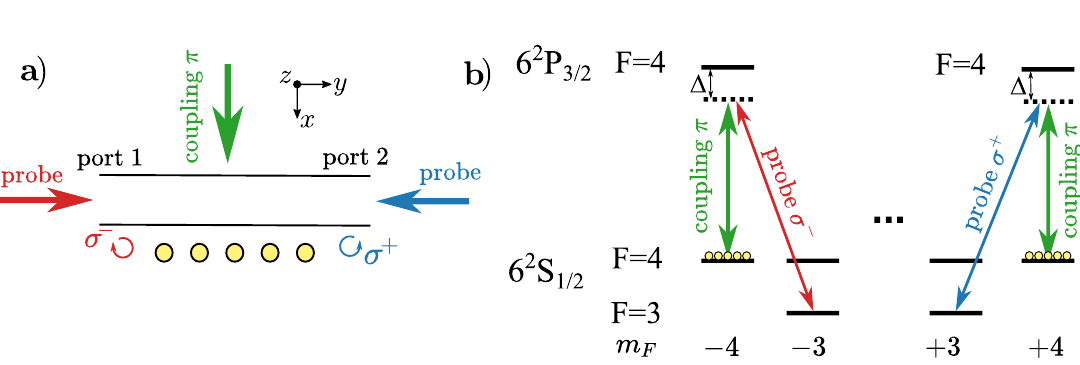
Figure 1. a) We trap cesium atoms (yellow circles) in a 1D array of trapping sites, close to an optical nanofiber. A probe laser field is launched either into port 1 or port 2 of the waveguide and interacts with the atoms via the evanescent part of the nanofiber-guided mode. The probe field is either predominantly σ − - or σ + - polarized at the position of the atoms. A π -polarized coupling laser field illuminates the atoms from the side. b) Energy levels relevant to our scheme. The atoms are initially prepared in | 6 2 S 1 / 2 , F = 4 , m F = − 4 (cid:105) . The probe and coupling laser fields couple to di ff erent Λ -system, depending on the probe polarization and initial atomic state.